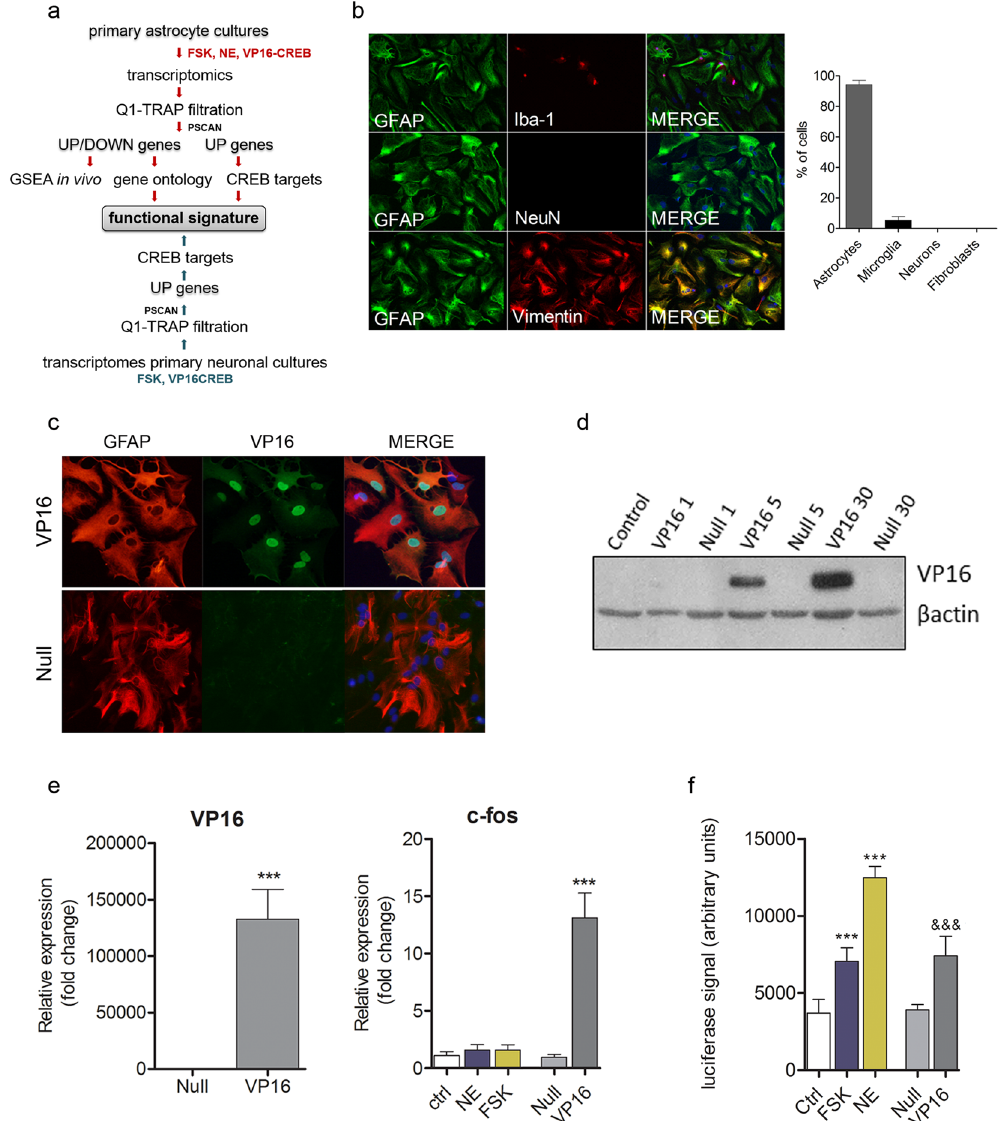
Figure 1. Outline and characterization of VP16-CREB over-expression in astrocytes. ( a ) Procedure outline. ( b ) Characterization of cellular composition. Cellular markers were GFAP (astrocytes), Iba1 (microglia), NeuN (neurons) and Vimentin, which labels both astrocytes (GFAP positive cells) and fibroblasts (GFAP negative cells). With respect to total DAPI counts, 95% of the cells were astrocytes, 5% microglia and no neurons or fibroblasts were detected − all Vimentin positive cells were GFAP positive as well. ( c – f ) Confirmation of VP16-CREB transduction. Astrocytes were incubated with Ad2/5-CMV-VP16-CREB or Ad2/5-CMV (Null) at MOIs within 1–30. ( c ) Immunodetection. The VP16-CREB is localized in the nucleus as expected for a CREB-like factor. Astrocytes and VP16-CREB were respectively identified by GFAP and VP16 immunostaining (viral infection at a MOI of 5). Infection with the Null virus showed no VP16-CREB expression. Images are representative of 3 independent experiments. ( d ) Western blots using anti-VP16 or anti-actin antibodies—the latter to control for equal protein load. VP16-CREB is 65 kd. Expression of VP16-CREB is MOI-dependent. The blot is representative of at least 3 independent experiments and is a cropped image. The full-length blot is presented in Supplementary Figure 1. ( e ) Left, robust up-regulation of VP16-CREB mRNA assessed by PCR in Ad2/5-CMV-VP16-CREB infected astrocytes but not in Null-infected ones. Data are means ± SEM of n = 3 independent determinations. ( *** ) p < 0.001, Student’s T-test. Right, VP16-CREB induced Fos upregulation in Ad2/5-CMV-VP16-CREB infected astrocytes at a MOI of 5. Fos was not detected upon stimulation with NE and FSK because these stimuli are transient and Fos is a short-lived gene. Data are means ± SEM of 3 independent experiments; ( *** ) p < 0.001, one-way ANOVA followed by Bonferroni. ( f ) Functional confirmation of VP16-CREB expression. VP16-CREB stimulates CRE-dependent transcription in luciferase-reporter assays (MOI = 5). FSK (1 μ M) and NE (10 μ M) were assayed in parallel as positive controls using 6-hour incubations. Data are means ± SD of an assay with four replicates representative of at least 5 independent experiments, ( *** /&&& ) p < 0.001, one-way ANOVA followed by